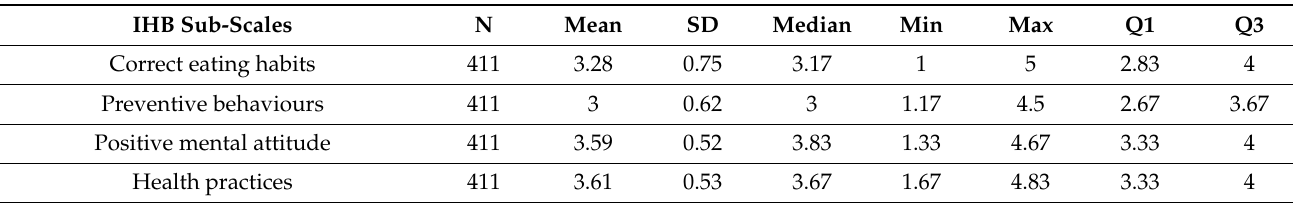
Table 10. Degree of intensity of specific categories of health behaviours according to the Inventory of Health-Related Behaviour (IHB) amongst